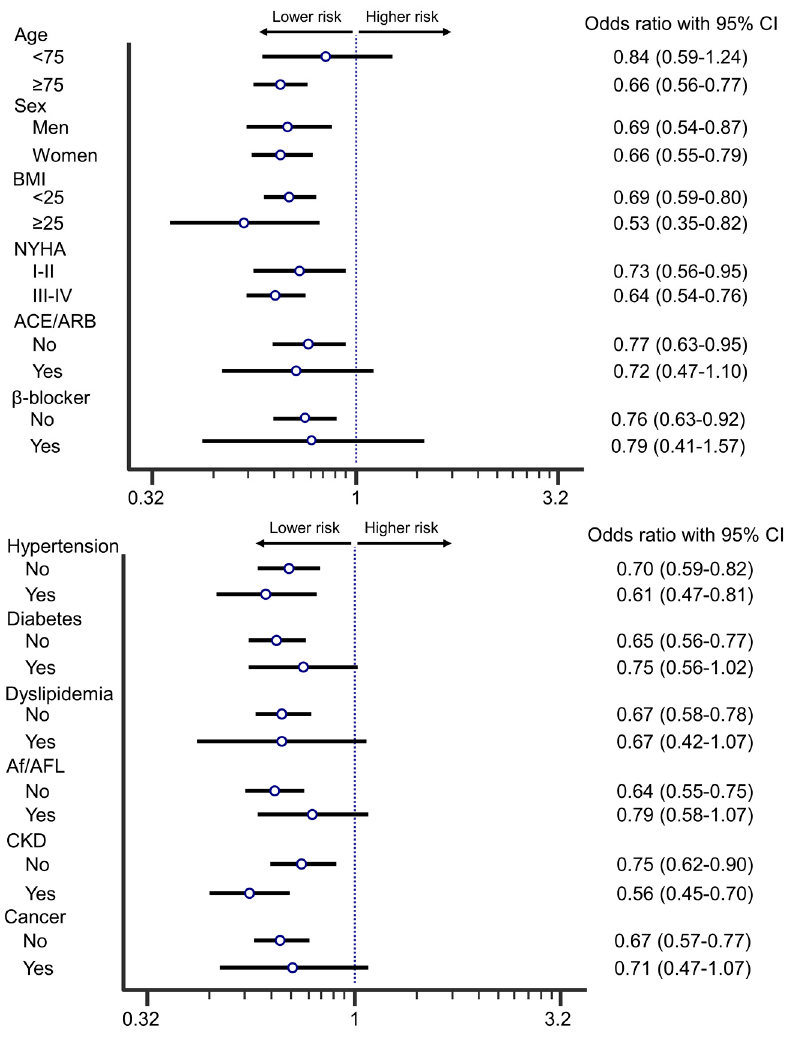
Figure 3. Odds ratio of in-hospital mortality. Patients with vitamin D compared with matched patients without vitamin D. Dots and lines mean OR and 95% CI,